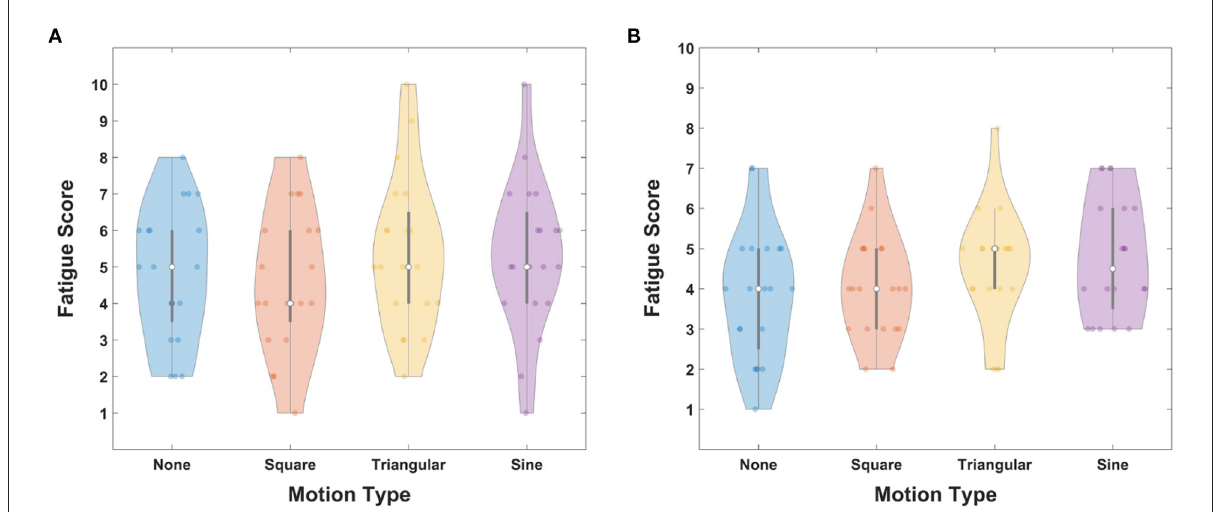
FIGURE6 Fatigue scores for (A) FS-based hybrid visual stimuli and (B) PRS-based hybrid visual stimuli as a function of waveforms. Gray bars represent the interquartile range from 25 to 75% and white circles indicate median